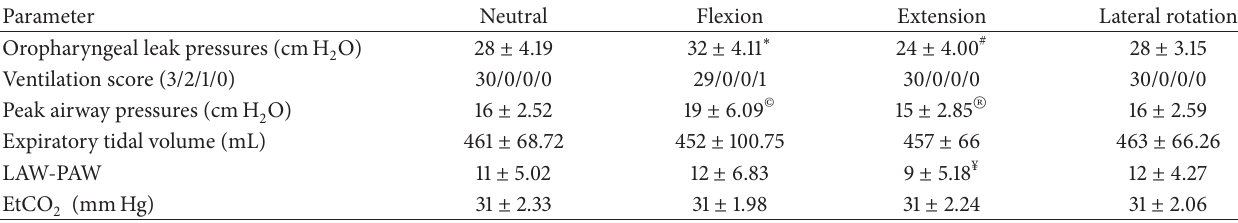
Table 2: Oropharyngeal leak pressures and ventilation with ProSeal LMA